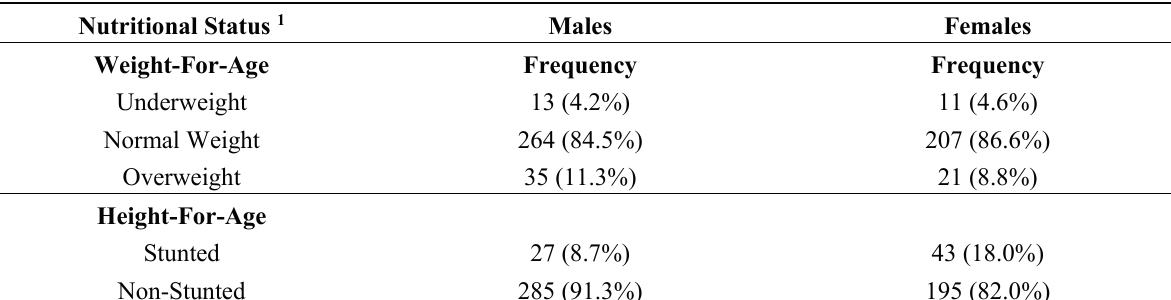
Table 2. Prevalence of nutritional status as a function of weight for age and height for age by sex in adolescents living at a moderate altitude. Nutritional Status 1 Males